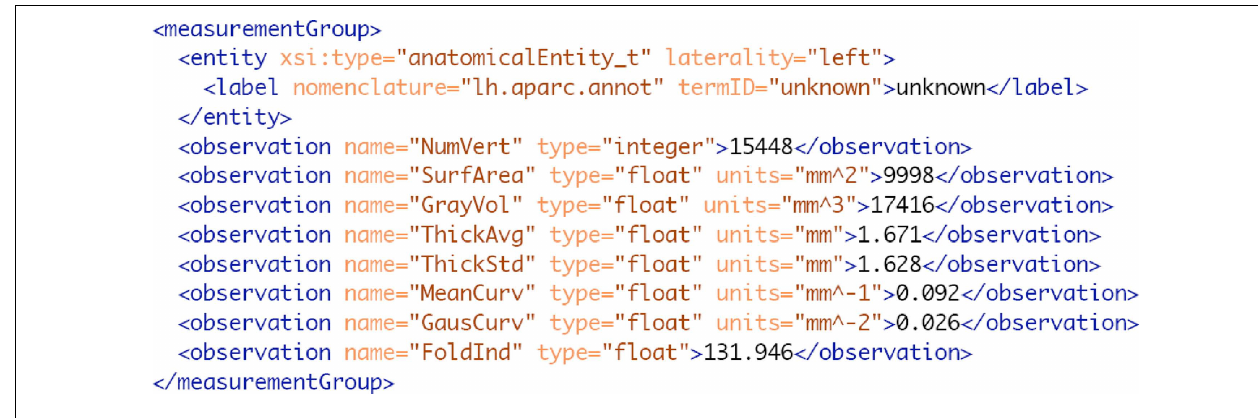
FIGURE 7 | XCEDE2 XML entry for thickness and curvature derived data. Entity tags document terminology source “rh.aparc.annot” and term “caudalmiddlefrontal” which is the native term and source within FreeSurfer analysis